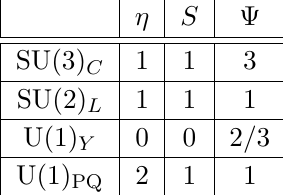
KSVZ model requires a complex scalar singlet η that breaks a global symmetry,